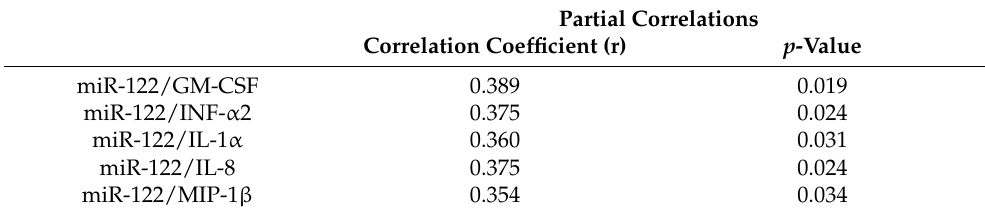
Table 2. Partial correlation between cytokines and miR-122 in AD controlled by gender (n = 40).